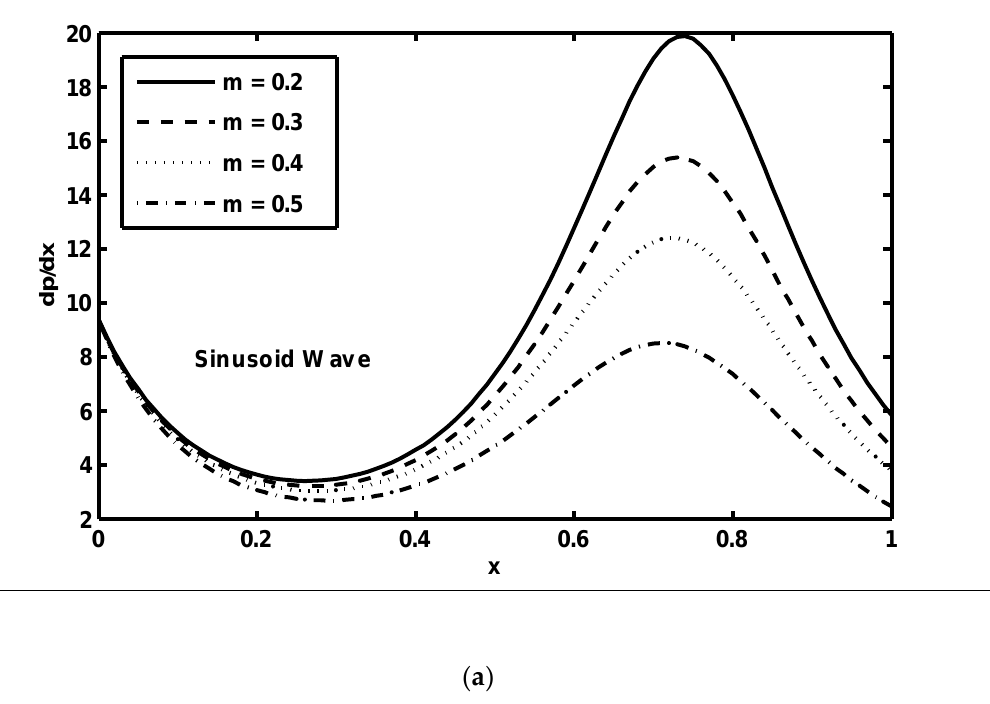
𝜋 , 𝛤 = 0.8, 𝛽 = 0.4, 6